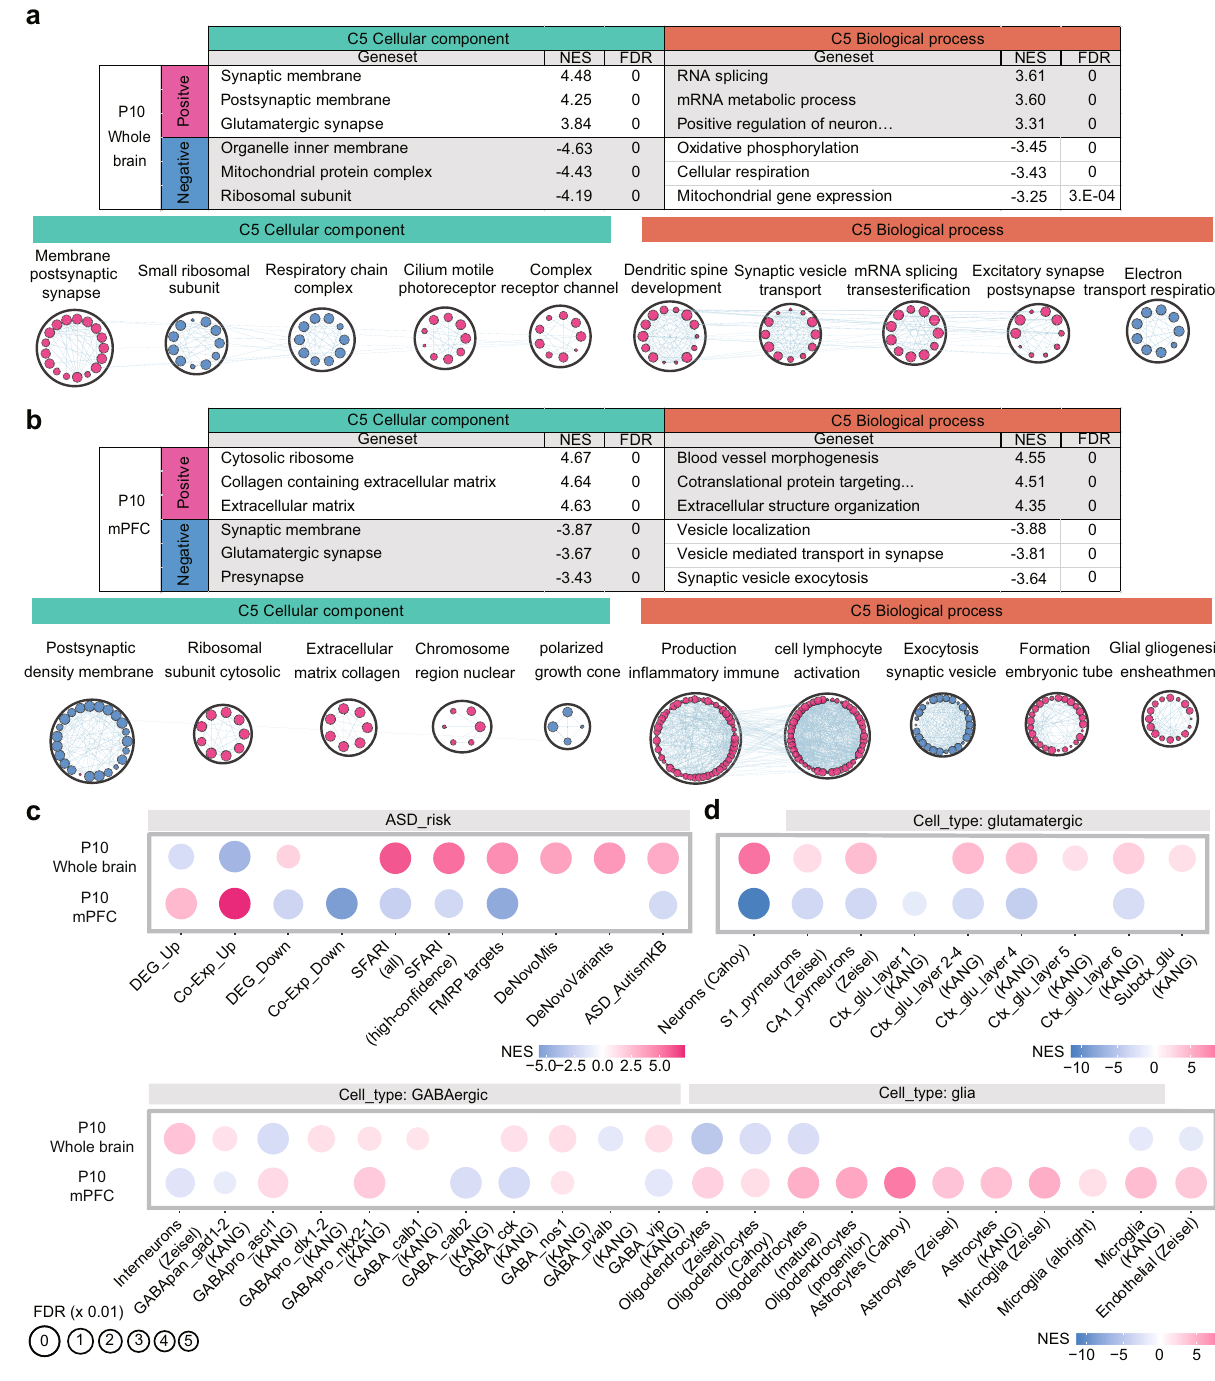
Fig. 2 | Synapse- and ASD-related transcriptomic changes in the whole brain and mPFC of Arid1b +/ – mice at P10. List of top- fi ve gene sets (ranked by p -value) positively or negatively enriched among Arid1b/WT transcripts from the whole- brain ( a ) and mPFC ( b ) of P10 males, determined by GSEA. CC and BP, cellular component(CC)andbiologicalprocess(BP)domainsintheC5gene-setdatabase (top), and functional clustering of the enriched gene sets from the GSEA results